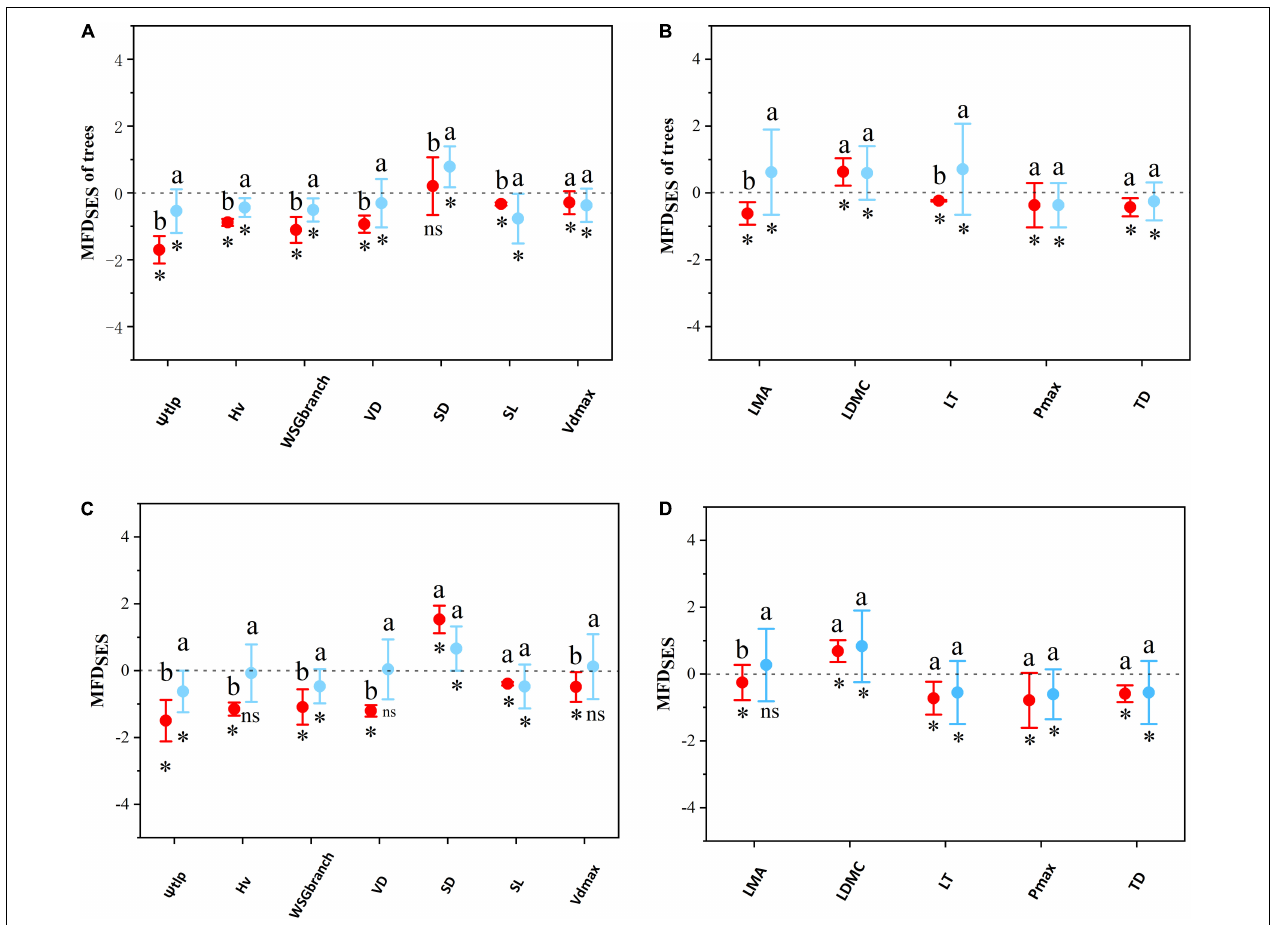
FIGURE 5 | The difference of community functional structures based on single traits between the Loess Plateau (LP) and the Qinling Mountain (QL). The functional structures were measured as standardized effect sizes (SES). (A) Test on single hydraulic traits in tree stratum. (B) Test on single economic traits in tree stratum. (C) Test on single hydraulic traits in the whole site. (D) Test on single economic traits in the entire site. Specifically, SES > 0 represents functional divergence, whereas SES < 0 indicates functional convergence. Each point shows the mean SES values among all plots within the LP and the QL. Error bars represent standard errors. Asterisks indicate significant differences between SES with 0. Different letters above bars (ab) indicate statistically significant differences at P ≤ 0.05 between the LP and the QL in the same